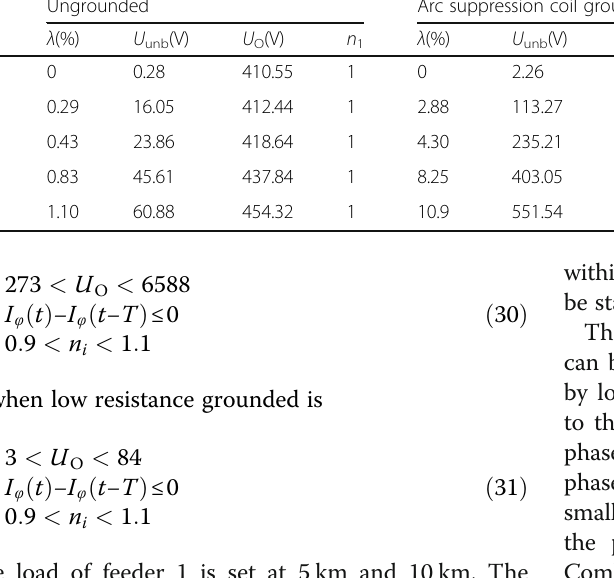
Table 4 Single-phase break fault with high resistance grounding Grounding resistance( Ω ) Ungrounded Arc suppression coil grounded